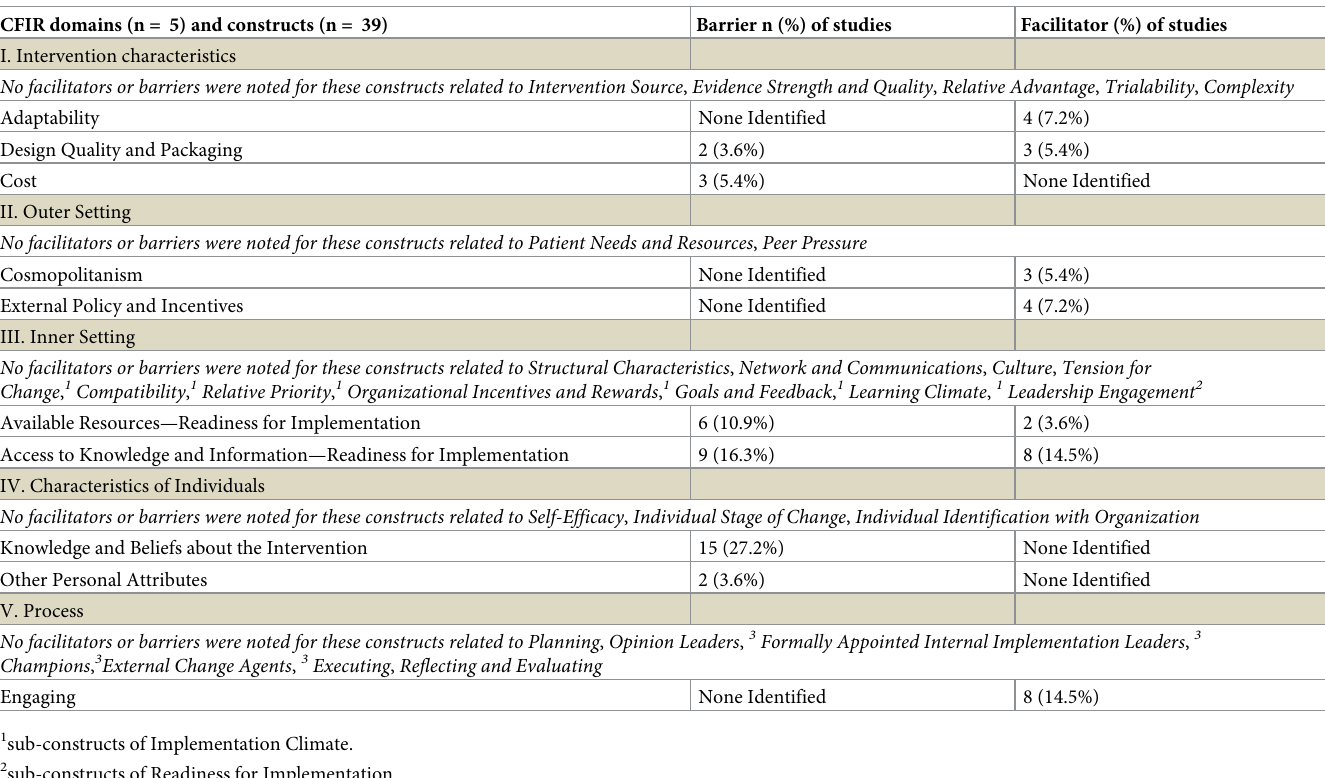
Table 2. Frequency table of cited Consolidated Framework for Implementation Research (CFIR) constructs (N = 55). CFIR domains (n = 5) and constructs (n = 39) Barrier n (%) of studies Facilitator (%) of